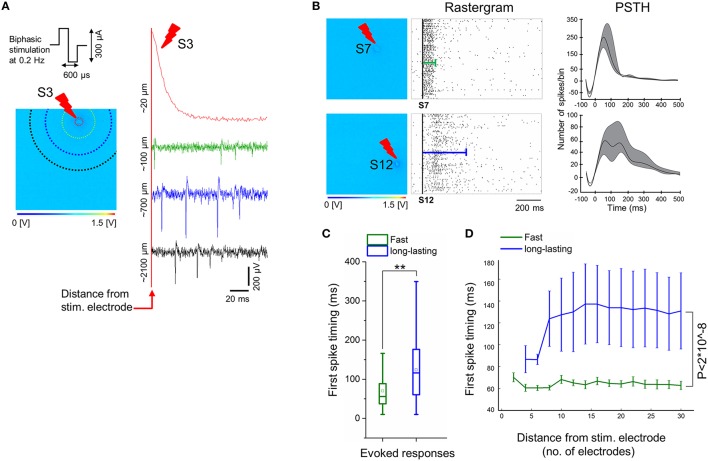
Electrical stimulation delivered by electrodes on-chip show evoked responses only at 90 DIV. (A) Sample of evoked signal traces illustrates the confined stimulation artifact to electrodes close to the stimulating electrodes (< 100 μm), e.g., when low-frequency (0.2 Hz) trains of biphasic current stimuli (300 μs per phase, peak-to-peak amplitude of 300 μA) is delivered for 3 min to exemplary electrode S3. Colors of signal traces correspond to the distance from the stimulating site, i.e., correlated with colors of dotted circles in the 64 × 64 array; for instance, the green response occurred at ~6 electrodes distance (~100 μm) from the stimulating site, while blue at ~15 electrode distance (~700 μm), and black trace at ~26 electrode distance (~2100 μm). (B) Exemplary electrical stimuli (S7 and S12) delivered by specific electrodes on the 4096 electrode arrays (left) and their corresponding evoked responses by means of rastergram and PSTH analyses (middle and right, respectively). Two forms of evoked responses were observed and show, fast responses lasting < 100 ms (top), and long-lasting responses up to ~500 ms (bottom). In the middle, rastergrams showing a sequence of evoked spikes that are confined within the green line (top), while evoked spikes are spread along the blue line (bottom). On the right, exemplary PSTHs that are computed from all evoked activities corresponding to their stimulating electrodes (see Materials and Methods). This shows that fast responses are characterized by a higher number of spikes per 25 ms bin size and lasting < 100 ms, in contrast with a lower number of spikes per bin and duration up to ~500 ms in case of long-lasting responses. Note that the negative tough in the PSTH is determined by the adopted artifact removal and smoothing procedures. (C) Average of the first spike timing delays with respect to electrical stimulation computed from two-group responses (fast vs. long-lasting). A delay of about 70 ms is observed from fast responses (green), while the onset of long-lasting responses (blue) occurred significantly over a longer period, i.e., 120 ms (n = 3, **p < 0.01). (D) The average of first spike timing is measured with respect to the distance from the stimulation site, by starting from four electrodes (~50 μm) until 30 electrodes (~2827 μm) after stimulus. This indicates that the first spikes in case of fast responses (green) occur within ~60–70 ms after stimulation, regardless of their distance from the stimulus, whilst, first spikes in long-lasting responses (blue) begins at ~85 ms, in close proximity to the stimulus (within four electrodes distance), and delayed to 120–140 ms in the distant ones. Non-significant differences of first spike timing between response (fast vs. long-lasting) and distance in μm (5, 10, 15, 20, 25, and 30) were determined by two-way ANOVA (p > 0.05). Responses of both groups (fast vs. long-lasting) are highly significant over the entire computed distance, i.e., ~2827 μm. (n = 3, p < 2*10∧−8, two-way ANOVA).